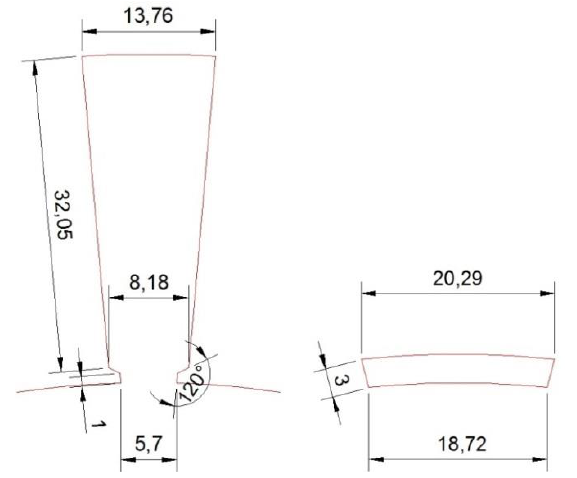
Figure 2. Slot and magnet dimensions (mm). Table 1. Parameters of the permanent magnet synchronous generator (PMSG)